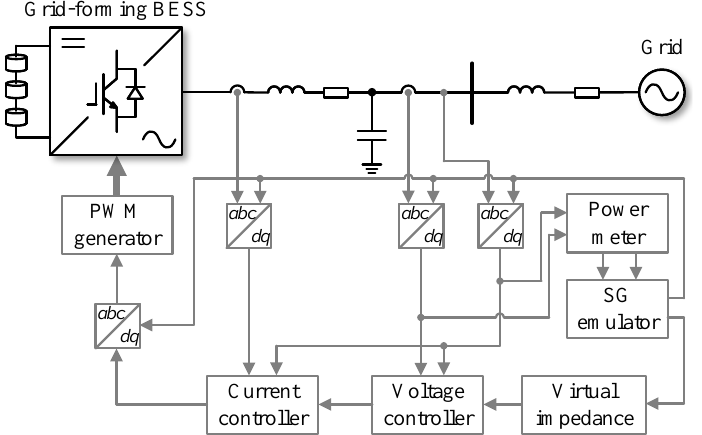
Figure 3. Control structure of a grid-forming battery energy storage